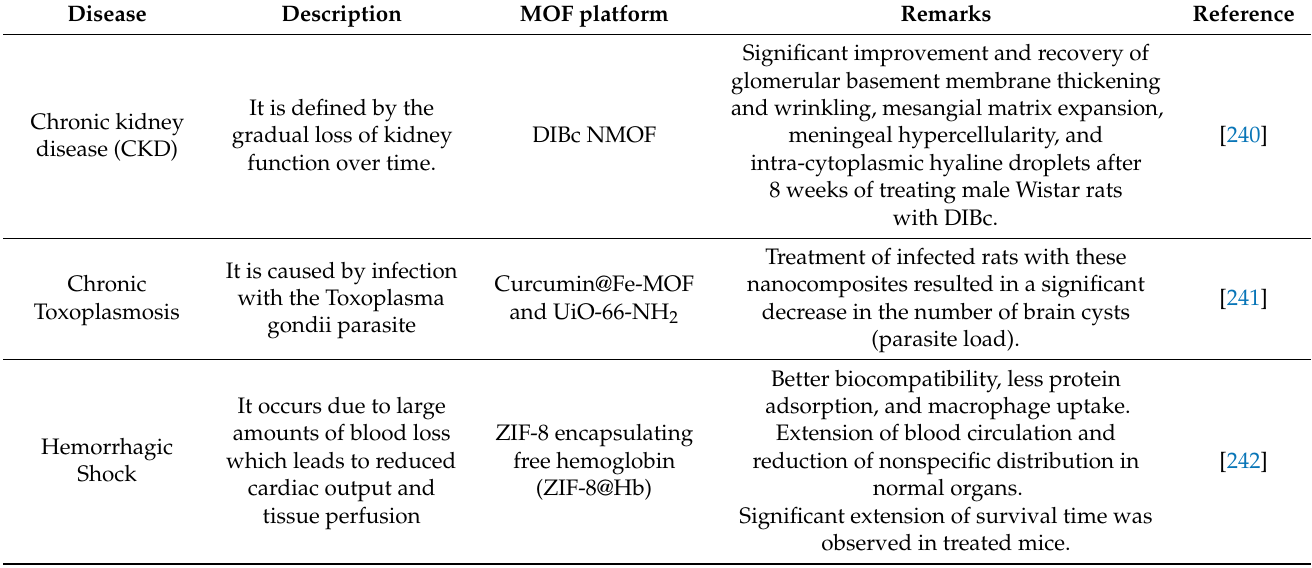
Table 8. MOFs used as therapeutic agents for other types of